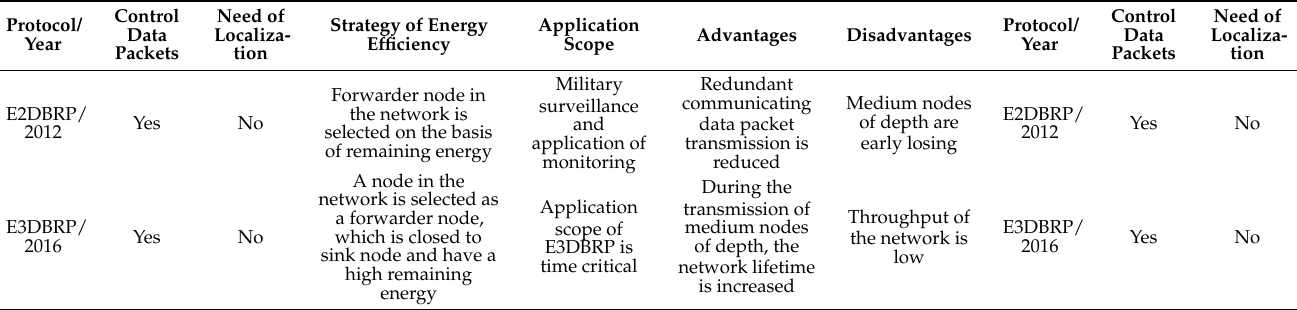
Table 12. Comparison of based-depth energy-efficient routing